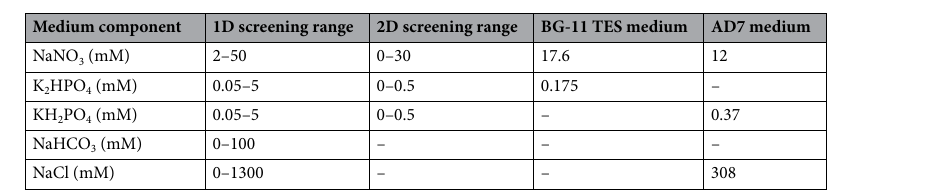
Table 1. Range of concentrations for 1D and 2D screening experiments of selected medium components used in this study. Reference values of concentrations in standard BG-11 TES and AD7 medium are given.